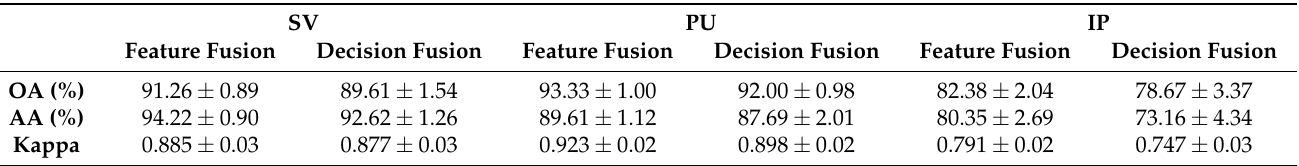
Table 11. Performance comparison with different fusion strategies. PU